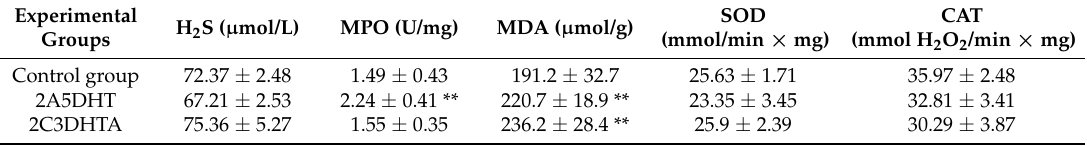
Table 2. The concentration of H 2 S in blood and activity of myeloperoxidase (MPO) and antioxidant enzymes (superoxide dismutase (SOD) and catalase (CAT)) and concentration of malondialdehyde (MDA) in small intestinal mucosa of rats treated by COX/LOX inhibitors. Mean ± SD, n = 8 in each group of animals.